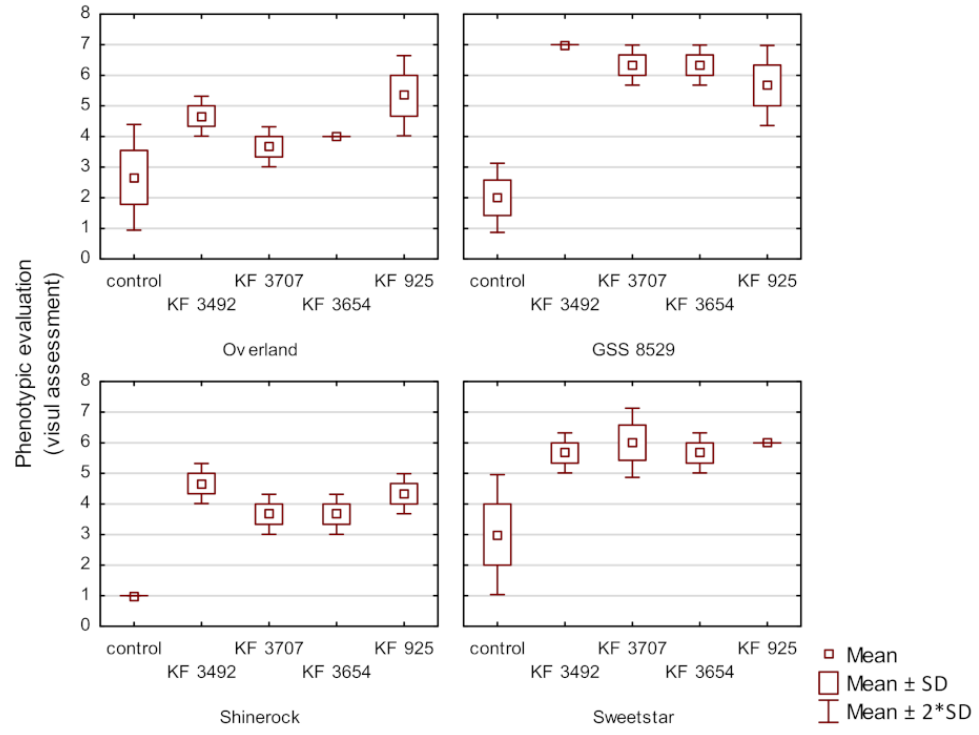
Figure 1. Mean values of ear rot resistance of four sweet maize cultivars (Overland, Sweetstar, GSS 8529 and Shinerock) inoculated with Fusarium verticillioides (KF 3492 and KF 3707 isolates) and Fusarium proliferatum (KF 3654 and KF 925 isolates) and under natural infection. Bars represent standard deviation